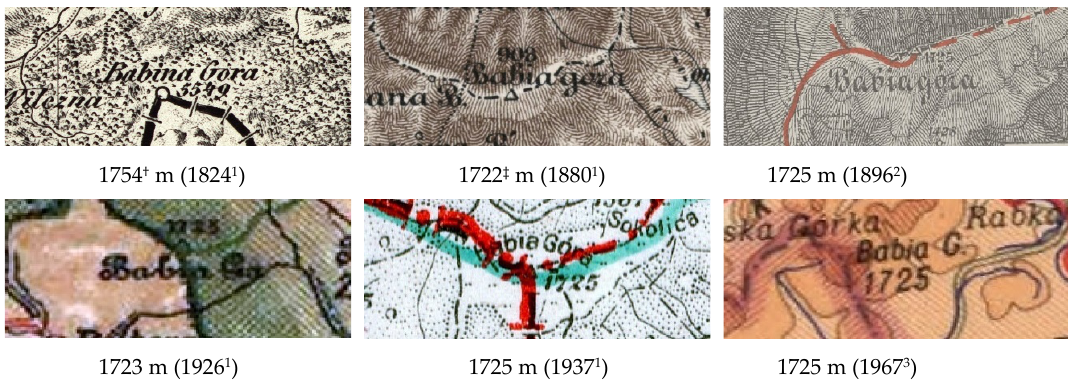
Figure 2. Changes in the published height of the Babia Góra summit over the years, since 1824. Source: 1 http://www.mapywig.org/, 2 https://polona.pl/ 3 https://www.davidrumsey.com/ † Vienna foot = 0.3161 m [3], ‡ Vienna fathom = 1.8966 m [3]